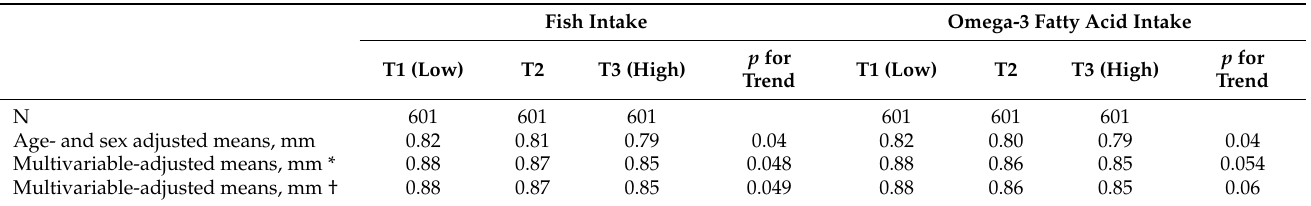
Table 2 shows age-, sex-, and multivariable-adjusted mean values of maximum C-IMT according to fish and omega-3 fatty acid intake tertiles, respectively. The fish and omega-3 fatty acid intakes were negatively associated with age- and sex-adjusted mean values of the maximum C-IMT. The association between the fish intake and maximum C-IMT remained after the adjustment for potential confounders. However, the association between the omega-3 fatty acid intake and maximum C-IMT did not reach significance. The multivariable-adjusted mean values of the maximum C-IMT for the lowest and high- est tertiles of fish intake were 0.88 mm and 0.85 mm ( p for trend = 0.048), respectively. The values for the lowest and highest tertiles of omega-3 fatty acid intake were 0.88 and 0.85 mm ( p for trend = 0.054), respectively. These associations were not altered after further adjustment for dyslipidemia. Table 2. Multivariable-adjusted means of maximum IMT reported via fish and omega-3 fatty acid intake